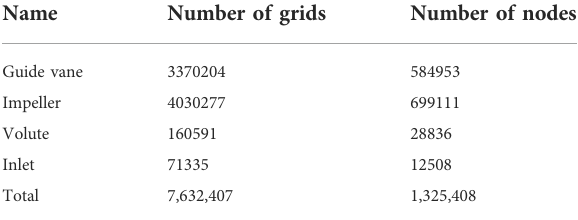
TABLE 4 Number of grids per